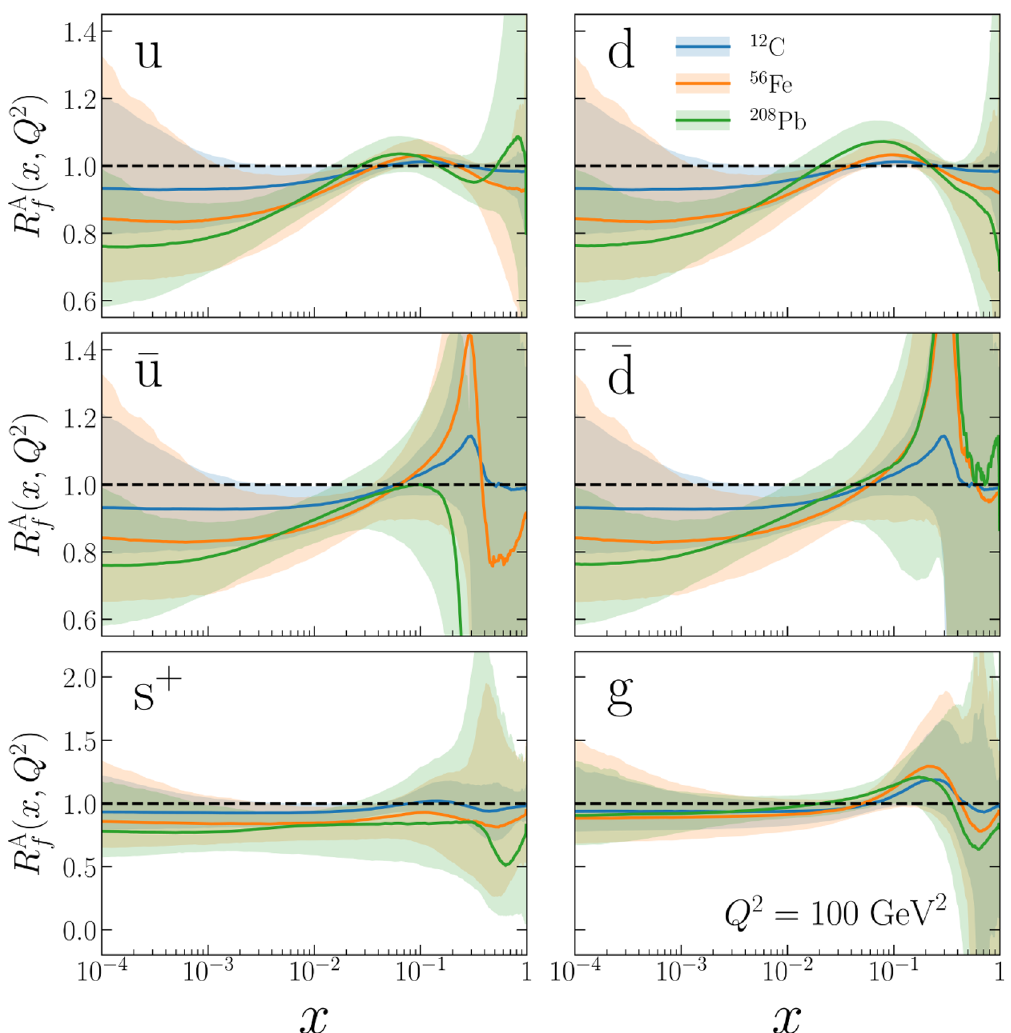
Figure 11 . Comparison of the nuclear PDF ratios, eq. (4.4), for three di(cid:11)erent nuclei, 12 C, 56 Fe, and 208 Pb, at Q = 10 GeV. From top to bottom we show the up and down quarks, the corresponding antiquarks, the total strangeness, and the gluon. The bands indicate the 90% con(cid:12)dence level intervals and take into account the correlations with the proton baseline used for the